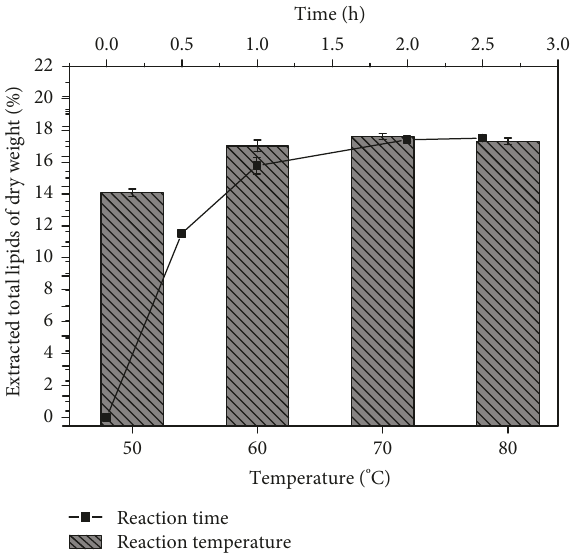
Figure 4: The in fl uence of reaction time and temperature on lipid extraction.